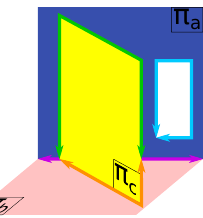
Figure 2. Representation of a (hatched) region grown on a red flat surface from the seed A associated with the inaccurate blue local plane. B is wrongly discarded from the region. Similarly, another region will be grown from B in which A will be discarded.